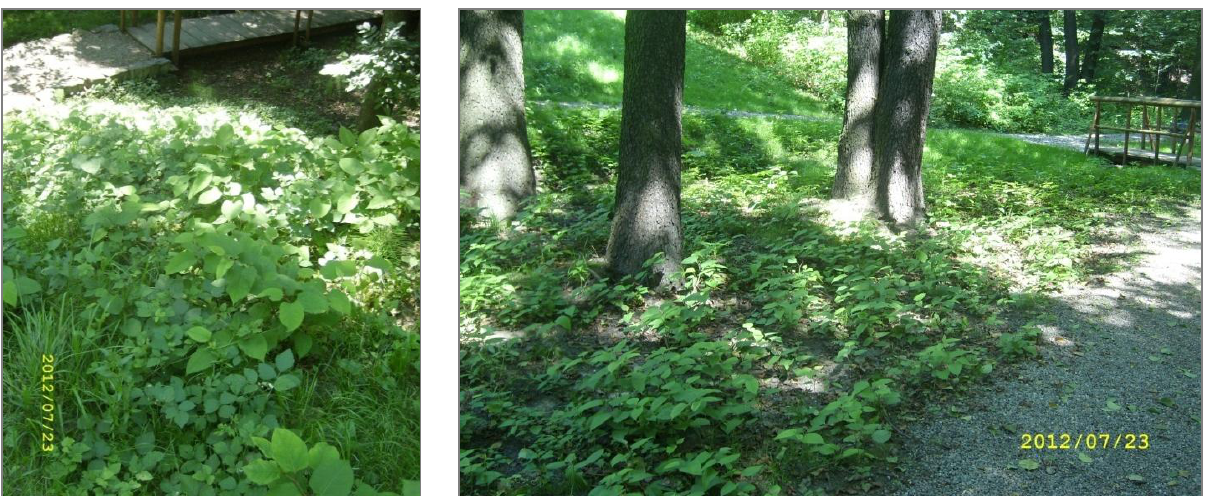
Fig. 6. A patch of Reynoutria japonica after application of the combined controls on the following areas: A – by a swamp, B – by a serpentine descent down the slope to the bottom of the valley ( M. Frelich ,